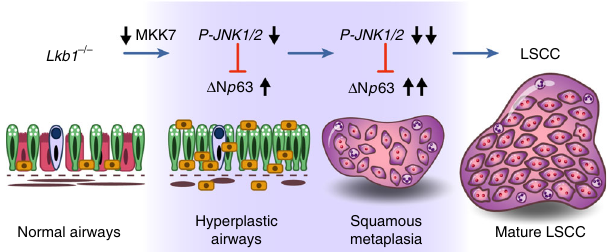
(Supplementary Fig. 1g), in Lkb1 d/d Pten d/d (Supplementary Fig. 3e) and in Lkb1 d/d Jnk1 d/d Jnk2 − / − (Fig. 4d) mice. Meanwhile,